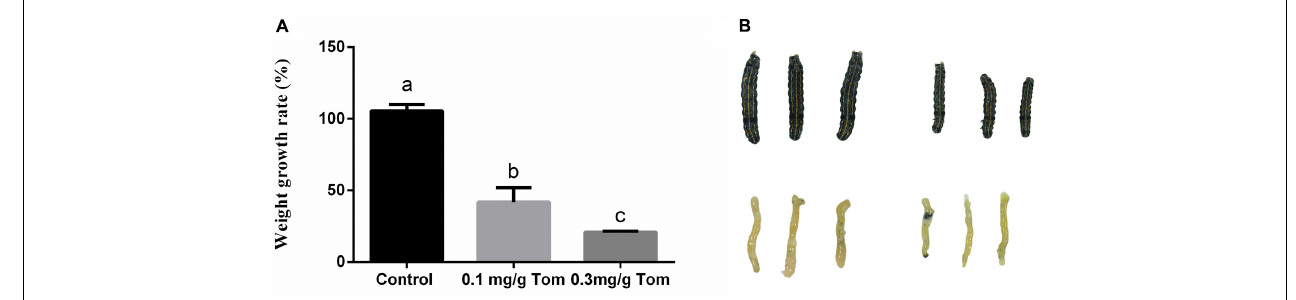
FIGURE 2 | The effect of exposing to tomatine on growth of S. litura and morphological of midgut tissue. (A) Effects of the presence and absence of tomatine in artificial diets (TOM, 0.1 mg/g, 0.3 mg/g) on weight growth rate ( n = 10, p < 0.05, Dunnett’s multiple range test). (B) Morphological changes in the phenotype and midguts of larvae fed a diet supplemented with tomatine; Control: larvae fed a diet supplemented with DMSO; tomatine: larvae fed a diet supplemented with 0.1 mg/g tomatine.